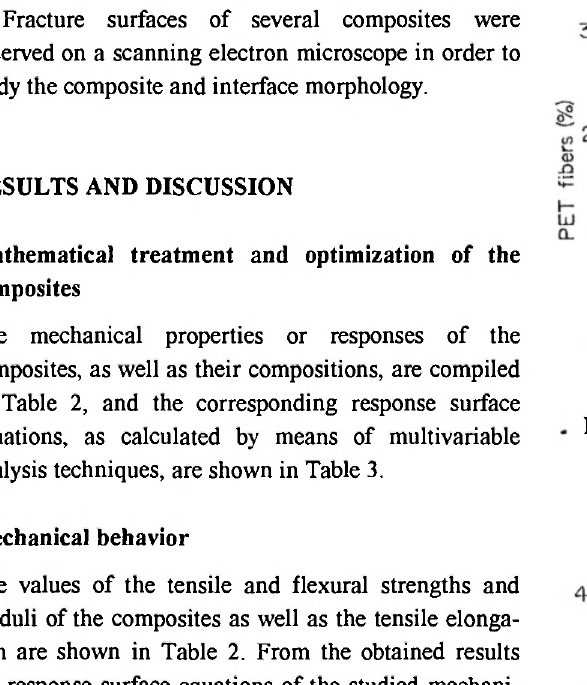
Fig. 1: Tensile modulus (MPa) of PET fiber-filled composites based on LDPE/PP blends as a function of matrix composition and fiber content.